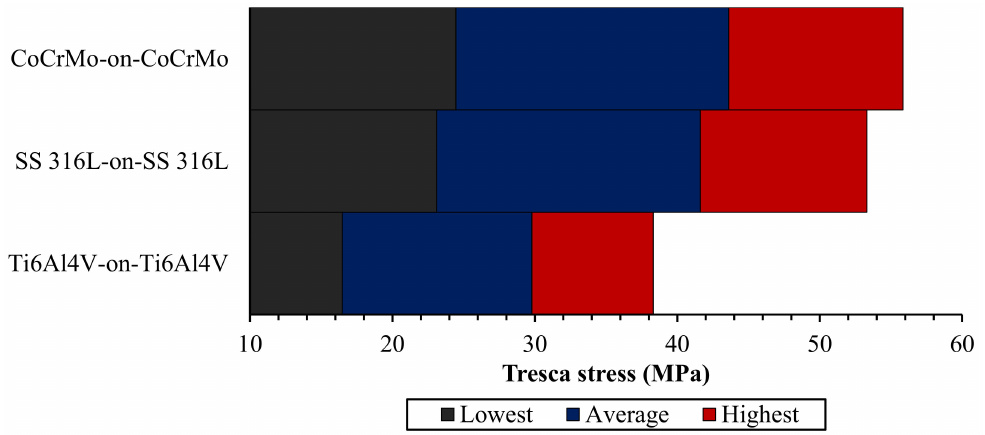
Figure 4. Comparison of highest, average, and lowest Tresca stress of metal-on-metal bearings materials on under normal walking condition.